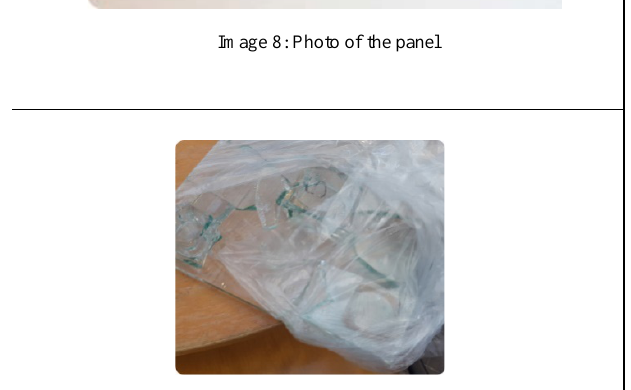
Image 9: panel after test